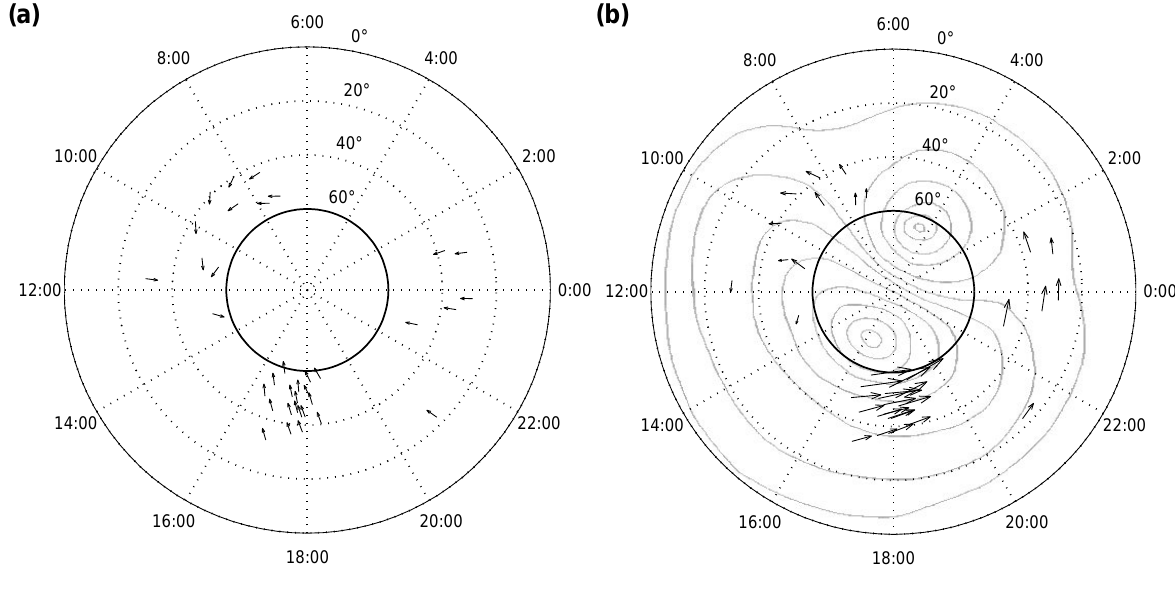
Fig. 6. ( a ) The orientation of the maximum correlation axis (M1) between the magnetospheric field B and the geomagnetic field for the entire set of ground stations. ( b ) The equivalent ionospheric current system superimposed to the current system proposed by Nishida (1968). The length of the arrows is proportional to the asymptotic